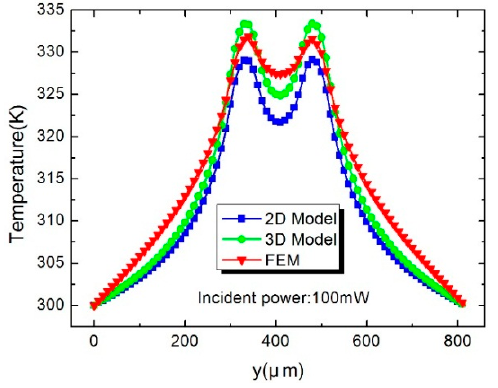
Figure 5. Temperature distribution in the AA ′ (x = 10 μ m) direction.